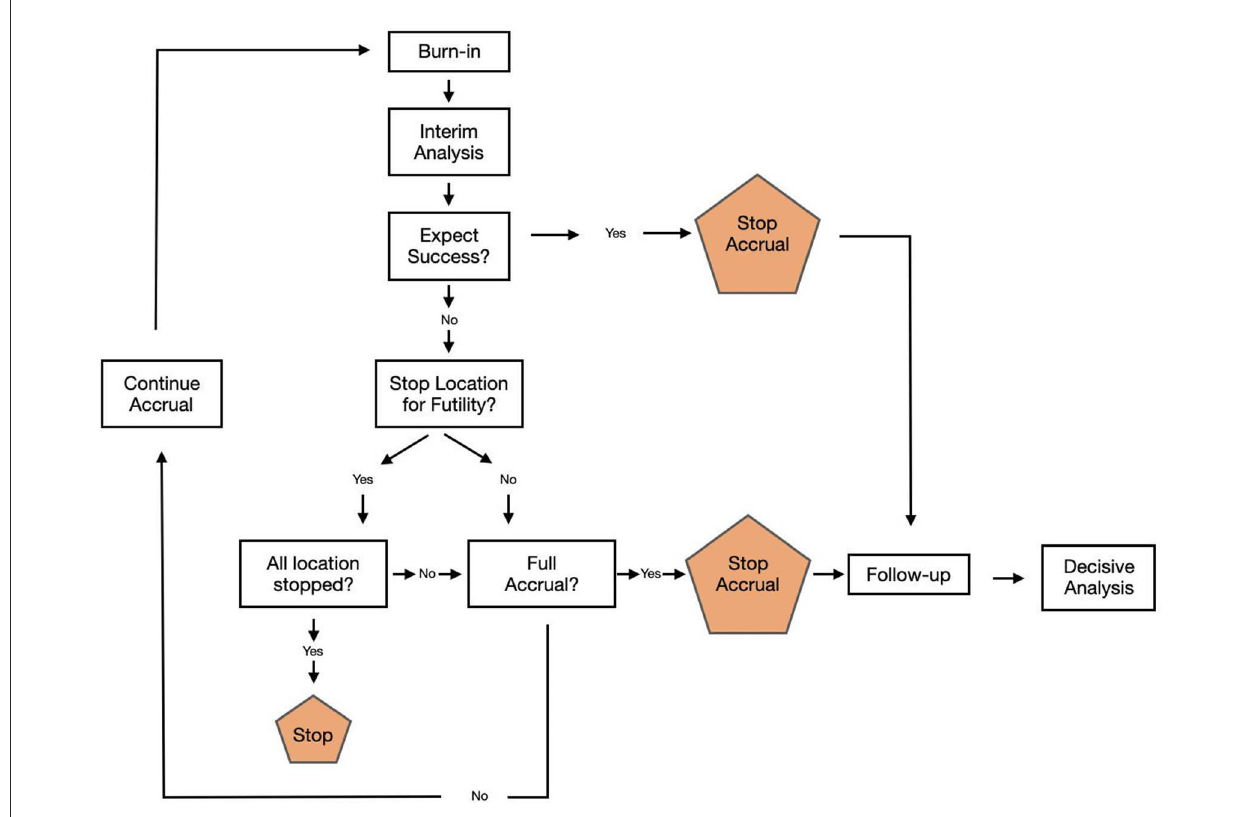
FIGURE1 Study flow